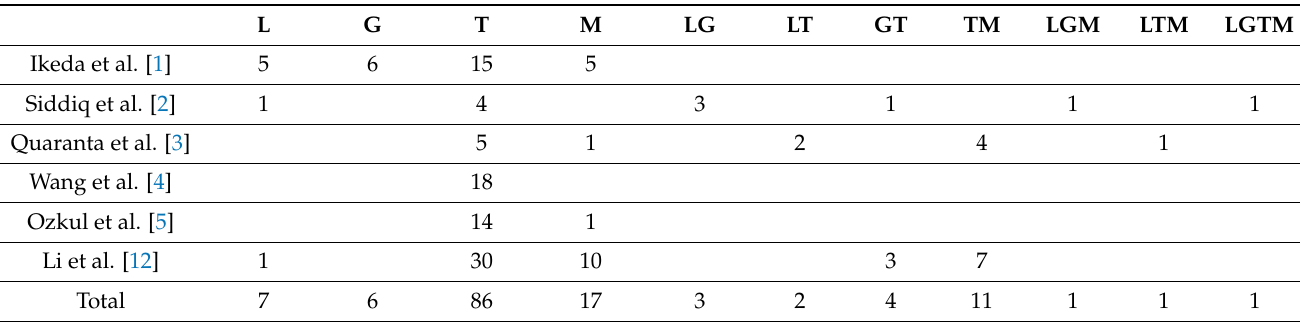
Table 4. Segment(s) of facial nerve damaged from cholesteatoma in different studies (total number